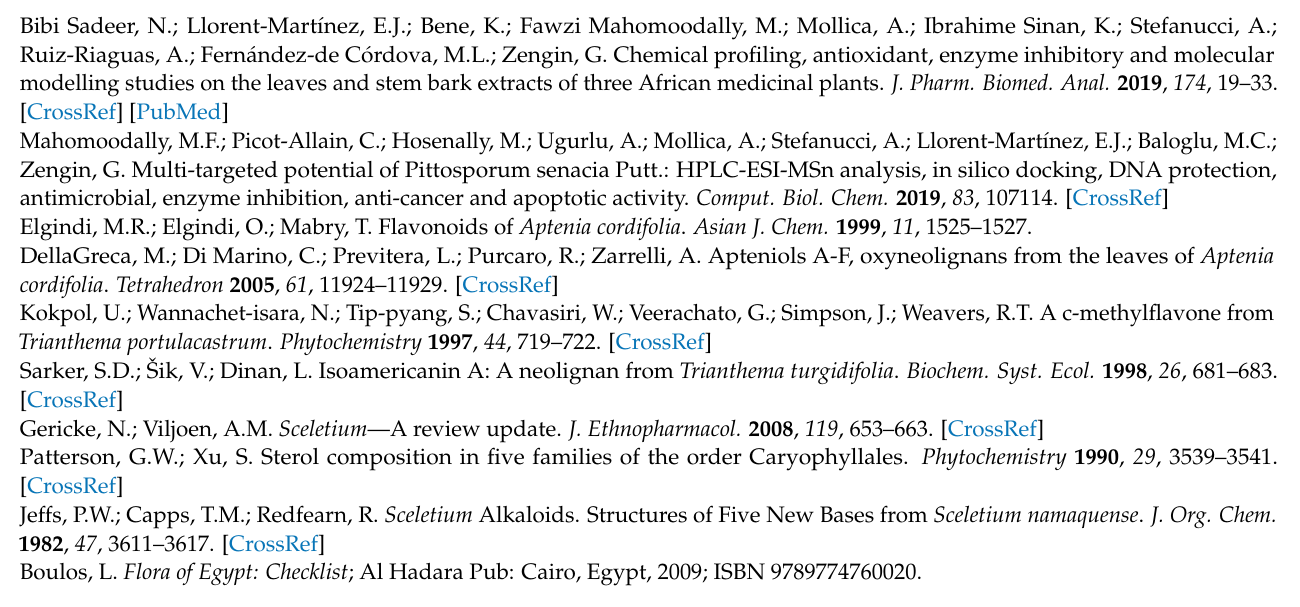
NMR of compound 2 ; Figure S4: 1D APT 13 CNMR of compound 2 ; Figure S5: HSQC of compound 2 ; Figure S6: COSY of compound 2 ; Figure S7: 1 H-NMR of compound 3 ; Figure S8: 13 C-NMR of compound 3 ; Figure S9: HSQC of compound 3 ; Figure S10: magnified HSQC of compound 3 ; Figure S11: 1 H-NMR of compound 4 ; Figure S12: 13 C-NMR of compound 4 ; Figure S13: HSQC of compound 4 ; Figure S14: 1 H-NMR of compound 5 ; Figure S15: HSQC of compound 5